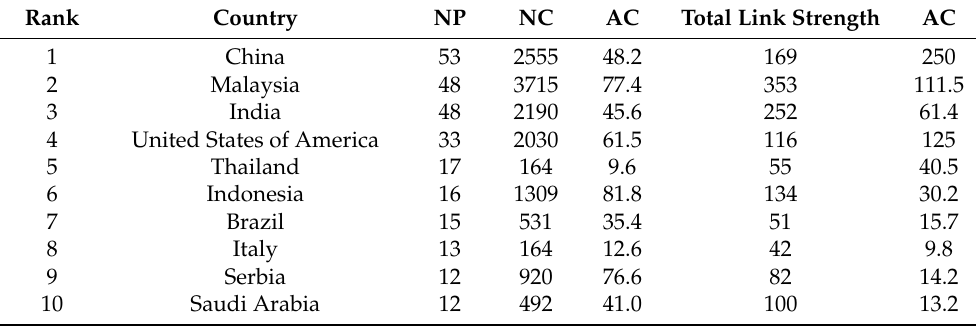
Figure 4. Network visualization map showing the collaboration among countries with at least five published papers. The thickness of the lines connecting two countries indicates the accumulation of co-authorships (thicker lines means more published articles), and the color clusters illustrate the groups of countries with a high level of collaboration.